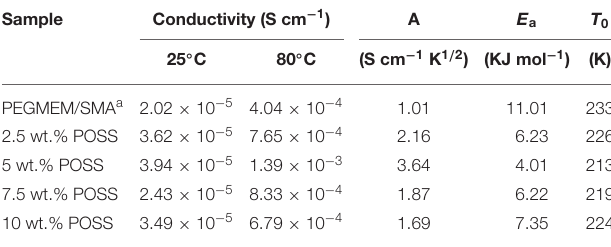
decline in the mobility of EO chains (Singh and Bhat, 2003). TABLE 2 | Ionic conductivity at 25 and 80 ◦ C and other parameters for the HPEs with various POSS contents at [EO]/[Li] of 10/1 derived from the VTF